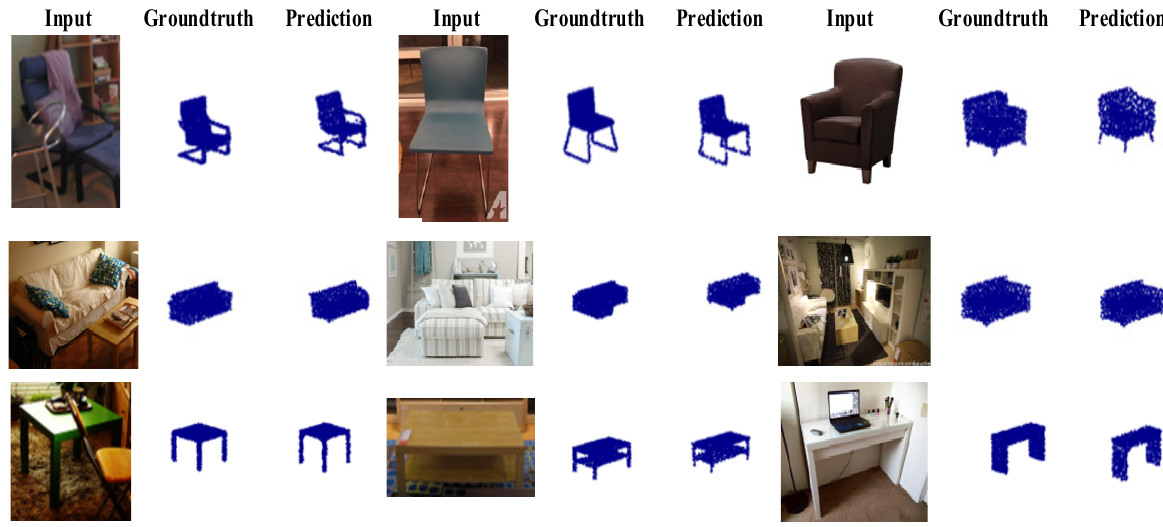
Figure 7. Visualization of our predictions on Pix3D.